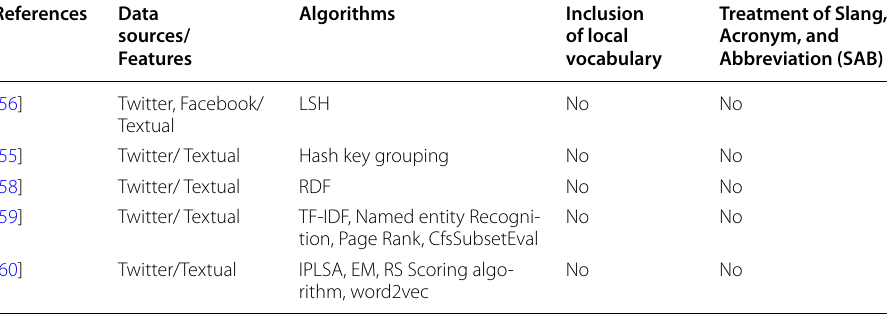
Table 4 A summary of semantic-based approaches used for event